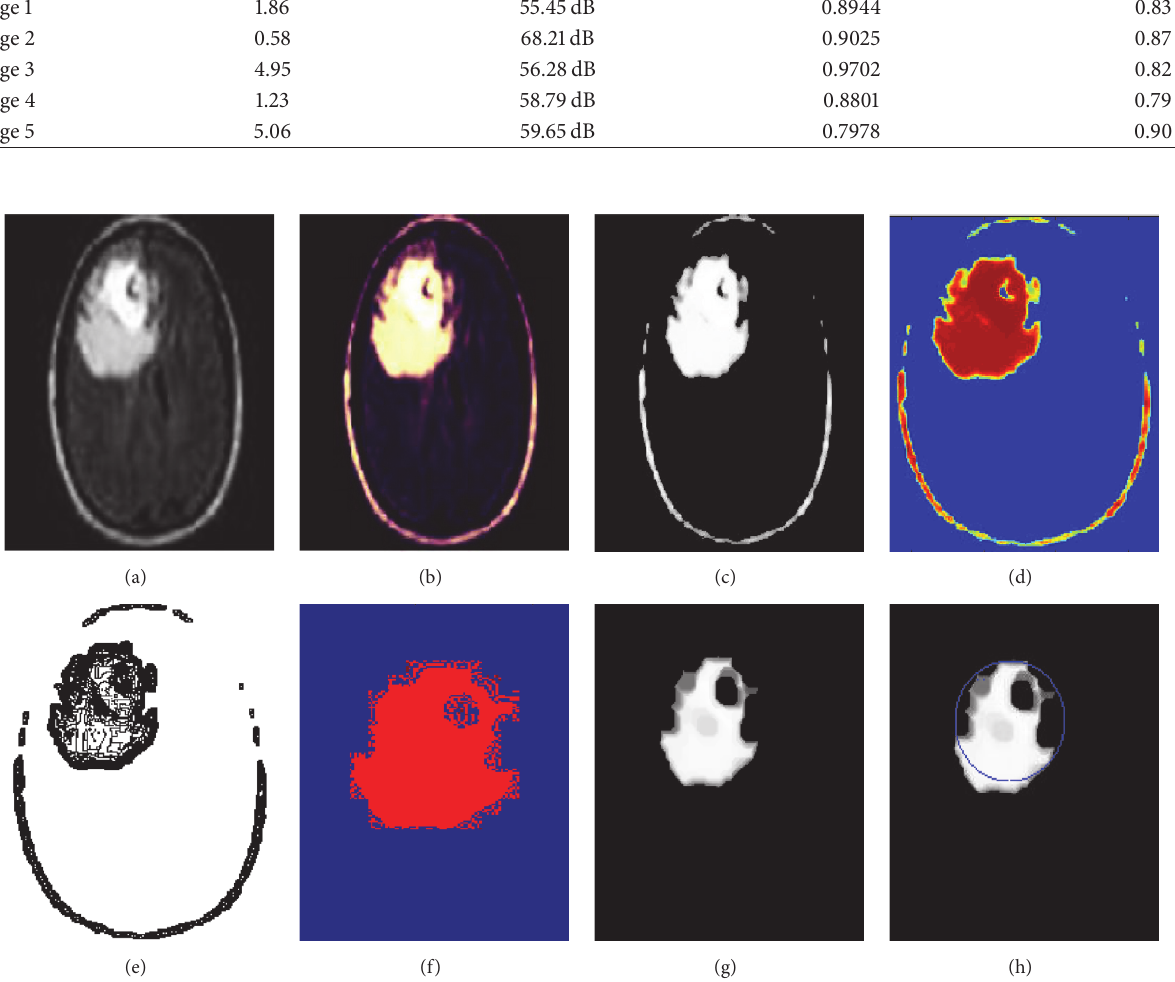
Figure 4: Experimental results of image 1. (a) Original image. (b) Enhanced image. (c) Skull-stripped image. (d) Wavelet decompose image. (e) Intense segmented image. (f) Dice overlap image. (g) Tumor region. (h) Area extracted tumor